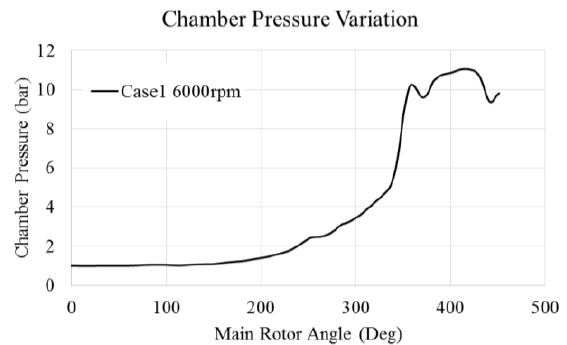
Figure 13. Internal chamber pressure variation during a compression cycle.